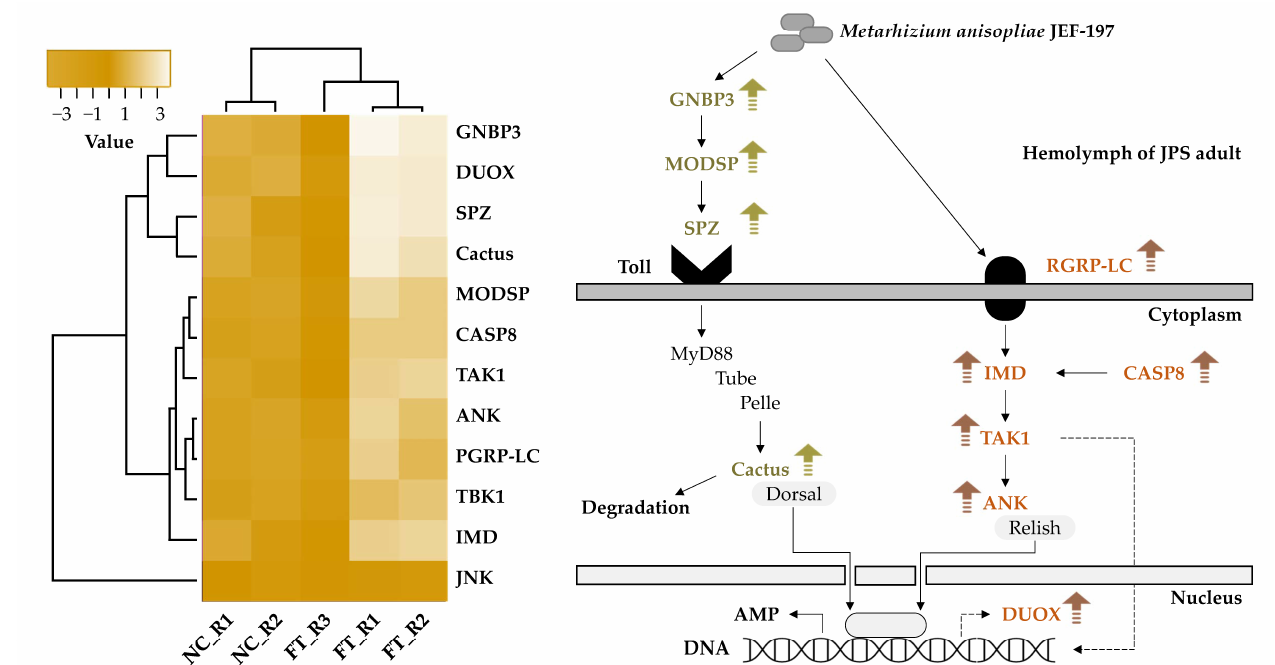
Figure 4. Expression of Toll and IMD pathway-related genes in Japanese pine sawyer adults treated with M. anisopliae JEF-197. ( a ) Heatmap of gene expression levels in JPS beetles as a result of fungal treatment. NC, non-treated control JPS adults, and FT, fungus-treated JPS adults. ( b ) Schematic diagram of Toll and Imd pathway genes with altered expression in response to fungal treatment of JPS beetles. GNBP3, Gram-negative bacterial binding protein 3; DUOX, dual oxidase; SPZ, spatzle; Cactus, NF-kappa-B inhibitor alpha; MODSP, modular serine protease; CASP8, caspase 8; TAK1, mitogen-activated protein kinase kinase kinase 7; ANK, ankyrin; PGRP-LC, peptidoglycan recognition protein LC; TBK1, TANK-binding kinase 1; IMD, immune deficiency; JNK, mitogen-activated protein kinase 8/9/10; Toll, protein toll; dMyD88, myeloid differentiation primary response protein MyD88; Tube, interleukin-1 receptor-associated kinase 4; Pelle, interleukin-1 receptor-associated kinase 1; Dorsal, dorsal; Relish, nuclear factor NF-kappa-B p105 subunit.